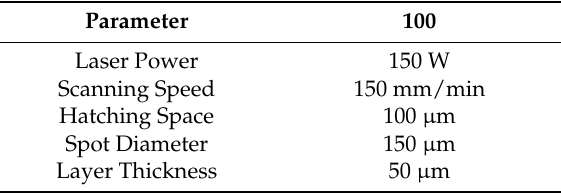
Table 3. The process parameters in the simulation and